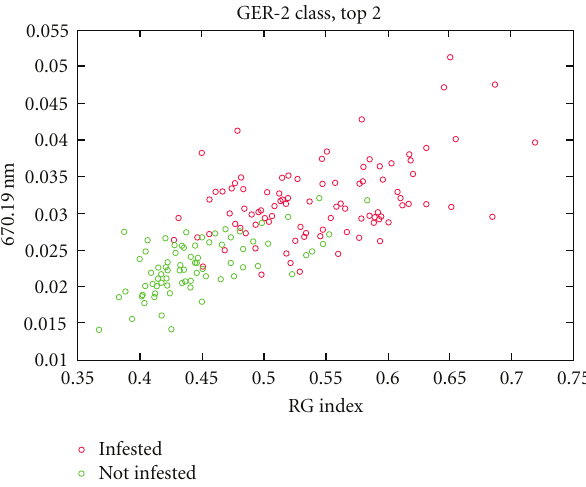
Figure 3: Values for the red green index (ratio of bands centered at 660 nm and 549nm, resp.) and percent reflectance in a narrow band centered at 670nm for individual trees infested or not infested with balsam woolly adelgid. The two variables were selected using a stepwise discriminant analysis procedure for distinguishing infested from noninfested trees.